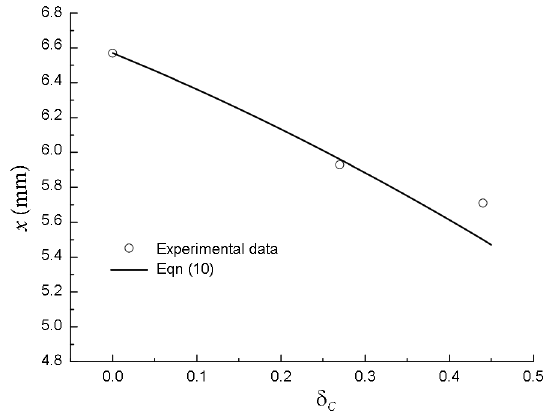
Figure 11. Comparison between the computed results from Eqn (10) and the experimental data from Liu (2008b)